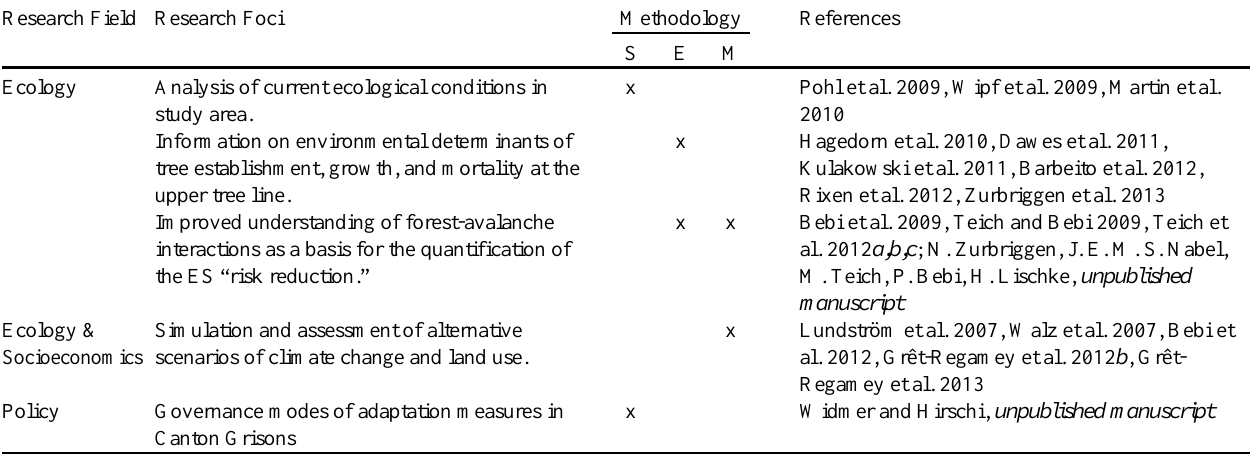
Table 3 . Research foci and methodologies temperature-sensitive inner Alpine region